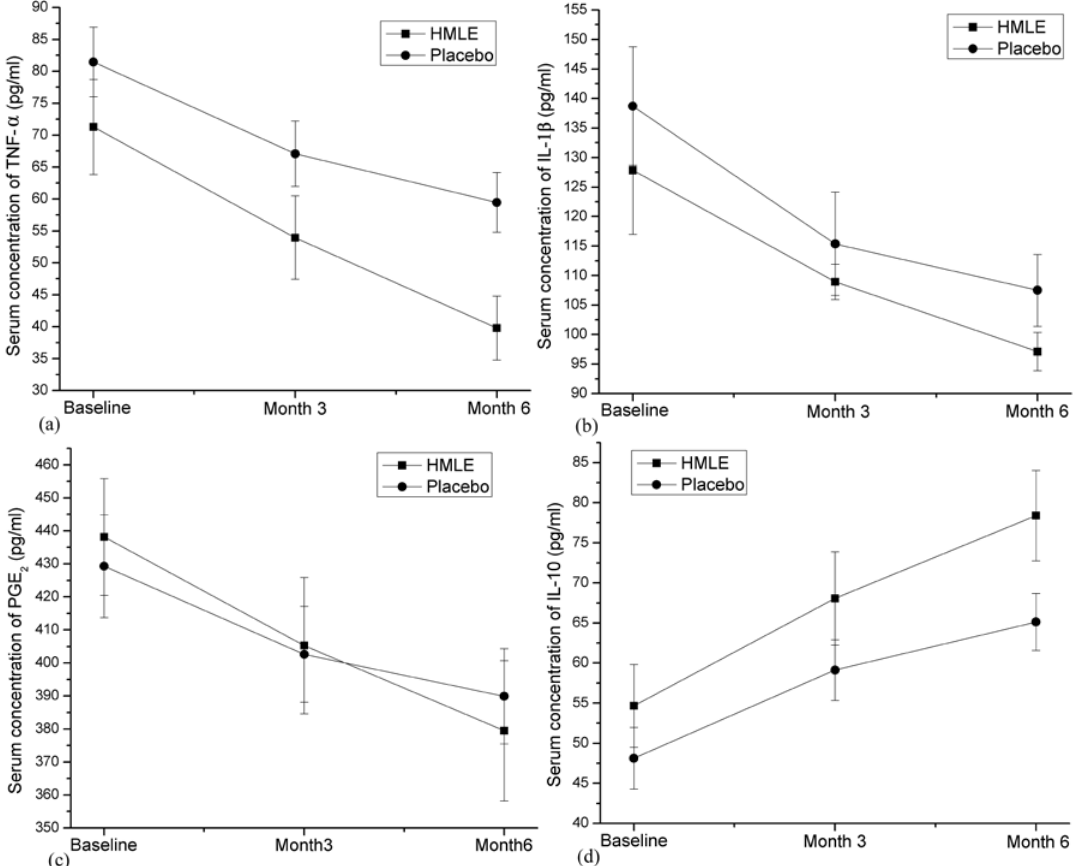
Figure 4. Changes over time in serum concentration of TNF-α ( a ); IL-1β ( b ); PGE 2 ( c ) and IL-10 ( d ). Error bars represent